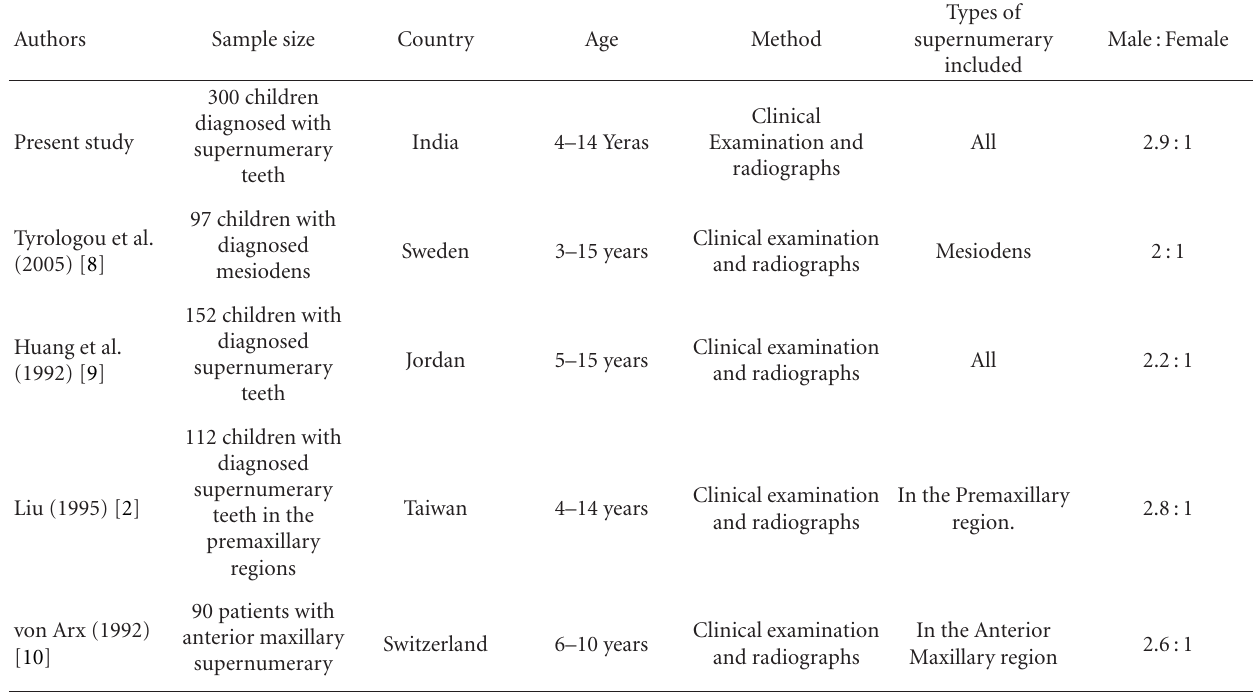
Table 4: Summary of various studies carried out on supernumerary teeth in di ff erent